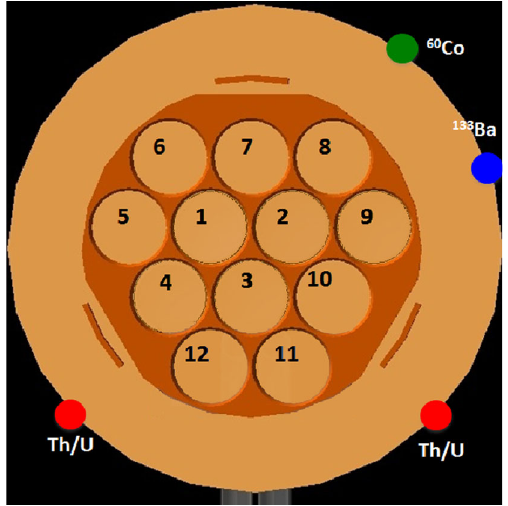
Fig. 8 AschematictopviewondetectorsplateinsidetheEDELWEISS set-up showing twelve slots for tower installation inside copper plates. The position and types of calibration sources are also